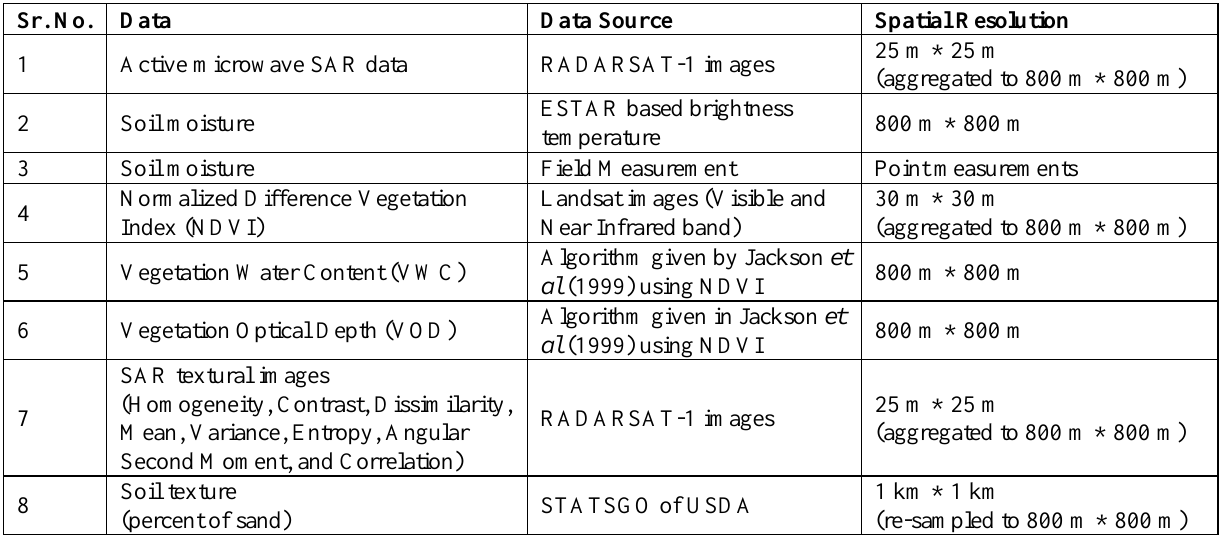
Table 1. Table shows type of data used in this